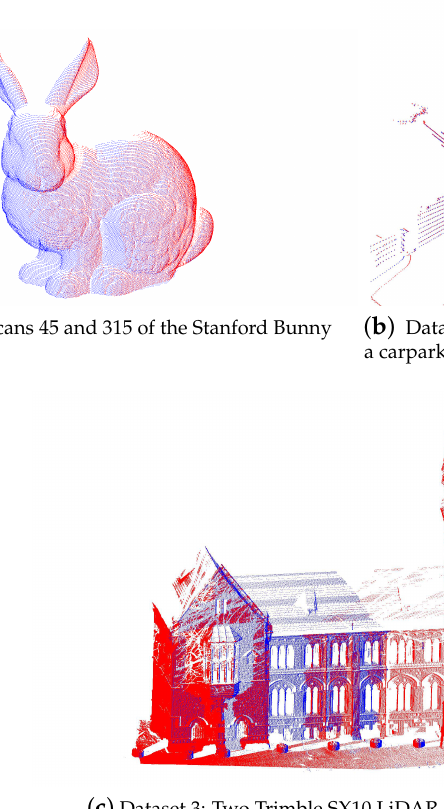
Figure 3. Test datasets. Each dataset has been chosen to represent a type of point cloud and application that PCL is commonly used for. Each dataset consists of an A (red) and B (blue) cloud which overlap but are